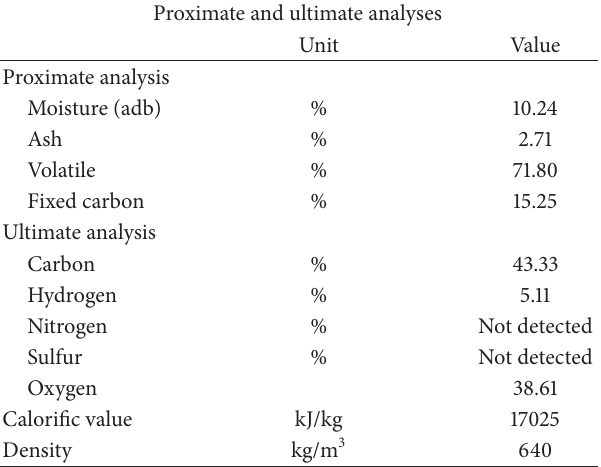
Table 1: Proximate and ultimate analyses